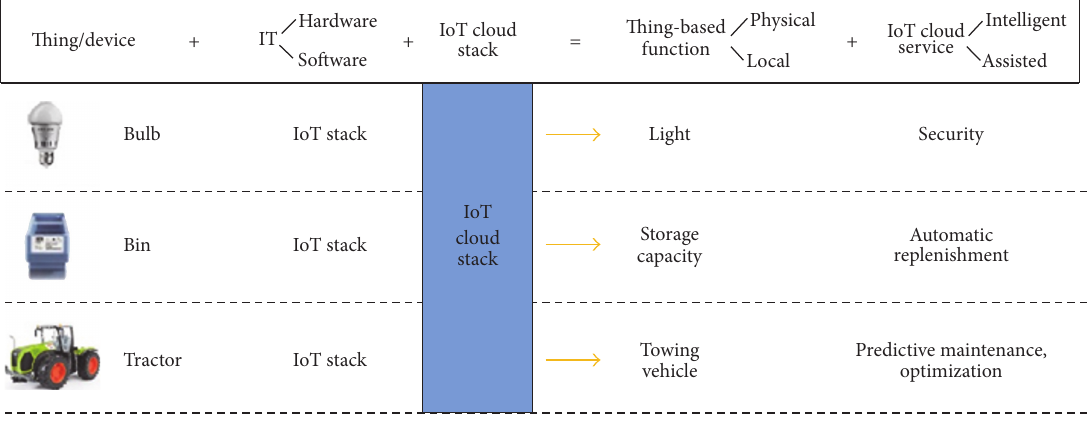
Figure 2: IoT cloud based value generation (based on